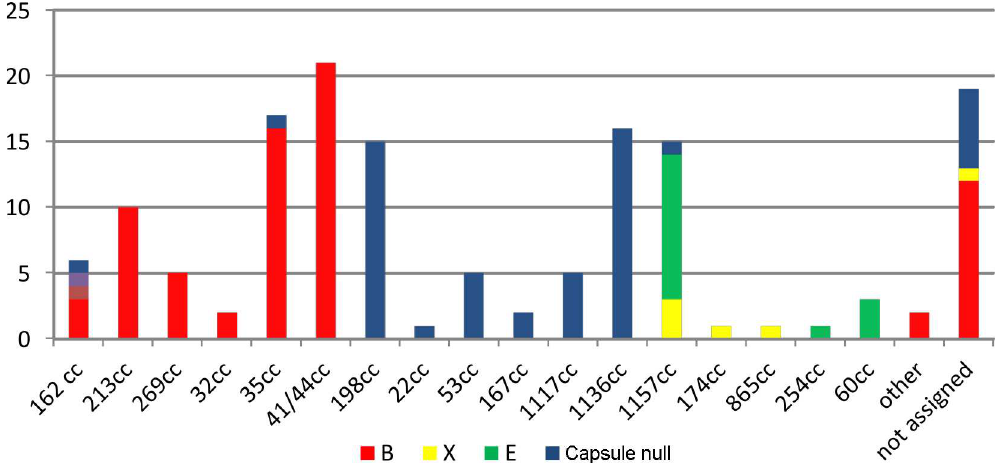
Fig 2. Genogroup assignment of the 145 meningococcal isolates to clonal complexes